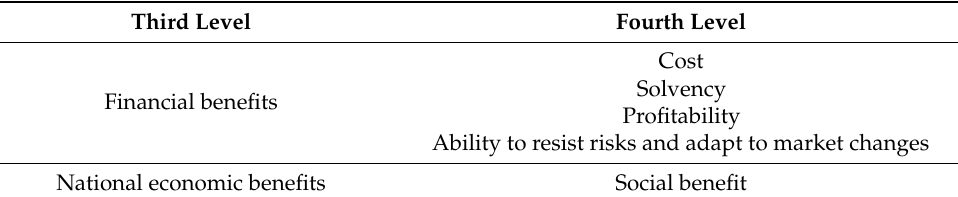
Table 3. Conditions and sub-conditions of